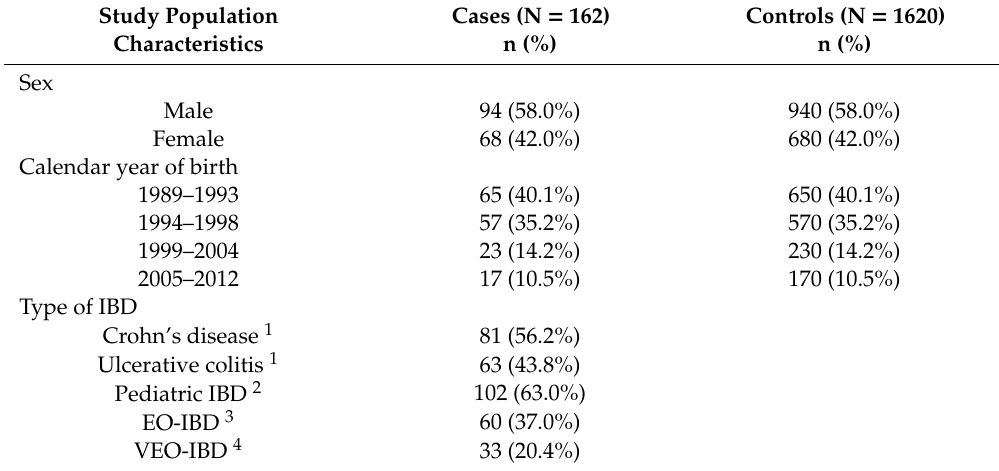
Table 1. Distribution by Sex, Year of Birth, Type of Inflammatory Bowel Disease (IBD), and Age at IBD onset among Cases and